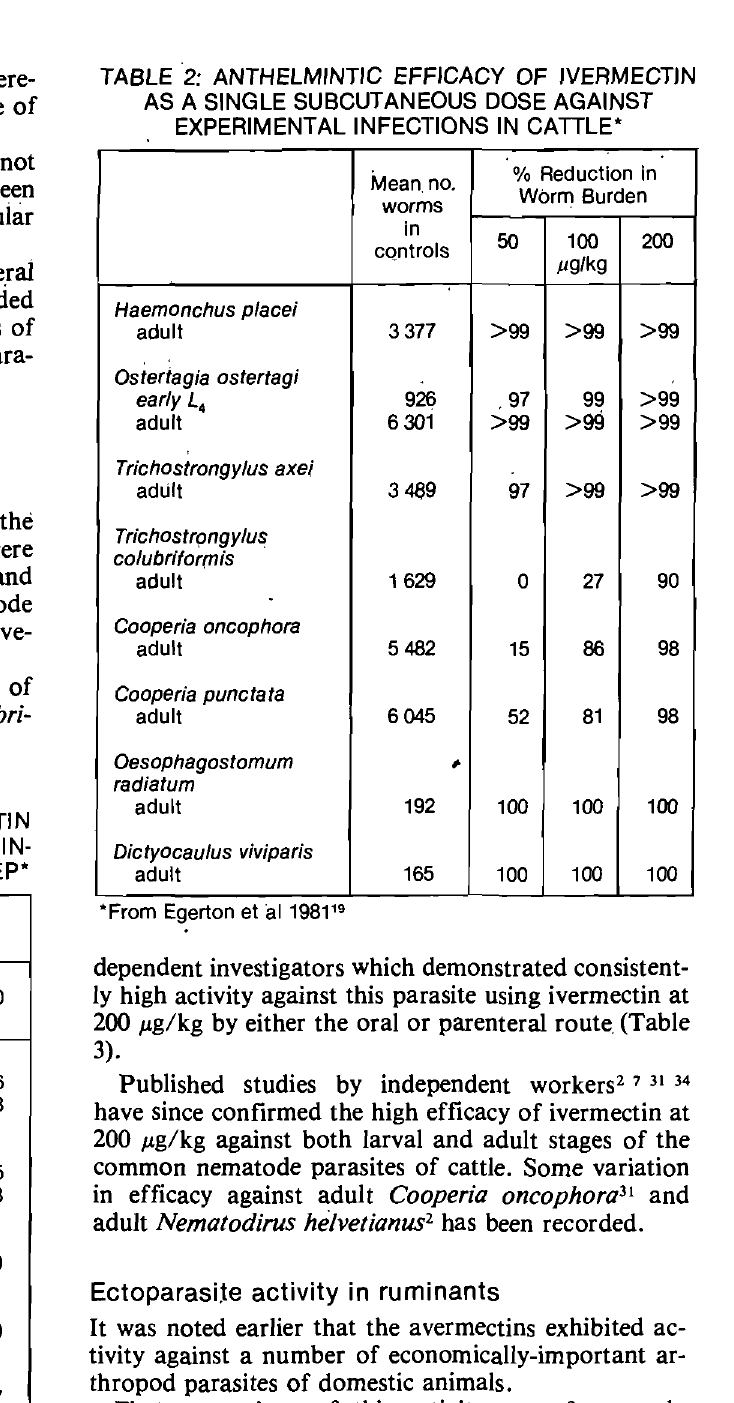
TABLE 1: ANTHELMINTIC ACTIVITY OF AVERMECTIN B, a BY ORAL ADMINISTRATION AGAINST PATENT IN FECTIONS IN EXPERIMENTALLY INFECTED SHEEP"